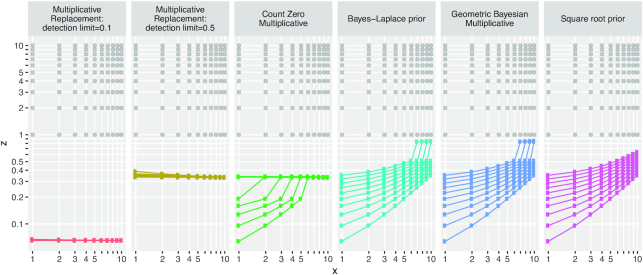
Five strategies for zero replacement (8) using the zCompositions package (36) applied to the three-part lattice compositions formed by the 1100 (x, y, \documentclass[12pt]{minimal}
\usepackage{amsmath}
\usepackage{wasysym}
\usepackage{amsfonts}
\usepackage{amssymb}
\usepackage{amsbsy}
\usepackage{upgreek}
\usepackage{mathrsfs}
\setlength{\oddsidemargin}{-69pt}
\begin{document}
}{}$z$\end{document}) triples where x and y are integers from 1 to 10, and \documentclass[12pt]{minimal}
\usepackage{amsmath}
\usepackage{wasysym}
\usepackage{amsfonts}
\usepackage{amssymb}
\usepackage{amsbsy}
\usepackage{upgreek}
\usepackage{mathrsfs}
\setlength{\oddsidemargin}{-69pt}
\begin{document}
}{}$z$\end{document} is an integer from 0 to 10. Each panel shows the lattice of counts for x and \documentclass[12pt]{minimal}
\usepackage{amsmath}
\usepackage{wasysym}
\usepackage{amsfonts}
\usepackage{amssymb}
\usepackage{amsbsy}
\usepackage{upgreek}
\usepackage{mathrsfs}
\setlength{\oddsidemargin}{-69pt}
\begin{document}
}{}$z$\end{document} with no zeros (the gray points) along with the value used to replace \documentclass[12pt]{minimal}
\usepackage{amsmath}
\usepackage{wasysym}
\usepackage{amsfonts}
\usepackage{amssymb}
\usepackage{amsbsy}
\usepackage{upgreek}
\usepackage{mathrsfs}
\setlength{\oddsidemargin}{-69pt}
\begin{document}
}{}$z$\end{document} = 0 (the colored points). Colored points connected by lines have the same y value (from 1 to 10). While all the gray points lie on the natural number lattice \documentclass[12pt]{minimal}
\usepackage{amsmath}
\usepackage{wasysym}
\usepackage{amsfonts}
\usepackage{amssymb}
\usepackage{amsbsy}
\usepackage{upgreek}
\usepackage{mathrsfs}
\setlength{\oddsidemargin}{-69pt}
\begin{document}
}{}$\mathrm{L}_{\mathbb {N}^2}$\end{document}, none of the zero replacements lie on the lattice of next lower magnitude \documentclass[12pt]{minimal}
\usepackage{amsmath}
\usepackage{wasysym}
\usepackage{amsfonts}
\usepackage{amssymb}
\usepackage{amsbsy}
\usepackage{upgreek}
\usepackage{mathrsfs}
\setlength{\oddsidemargin}{-69pt}
\begin{document}
}{}$\mathrm{L}_{0.1\mathbb {N}^2}$\end{document}.